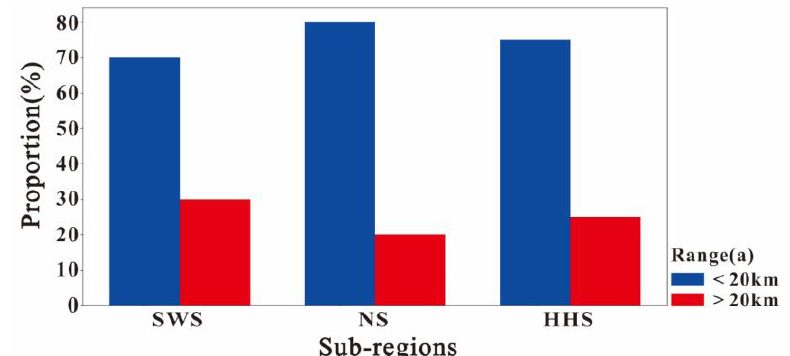
Figure 13. With the spatial resolution of 20 km as an example, the distribution of ranges for the DEM semi-variogram in different sub-regions: southwest winter wheat sub-region (SWS), north winter wheat sub-region (NS), and Huang-Huai winter wheat sub-region (HHS).